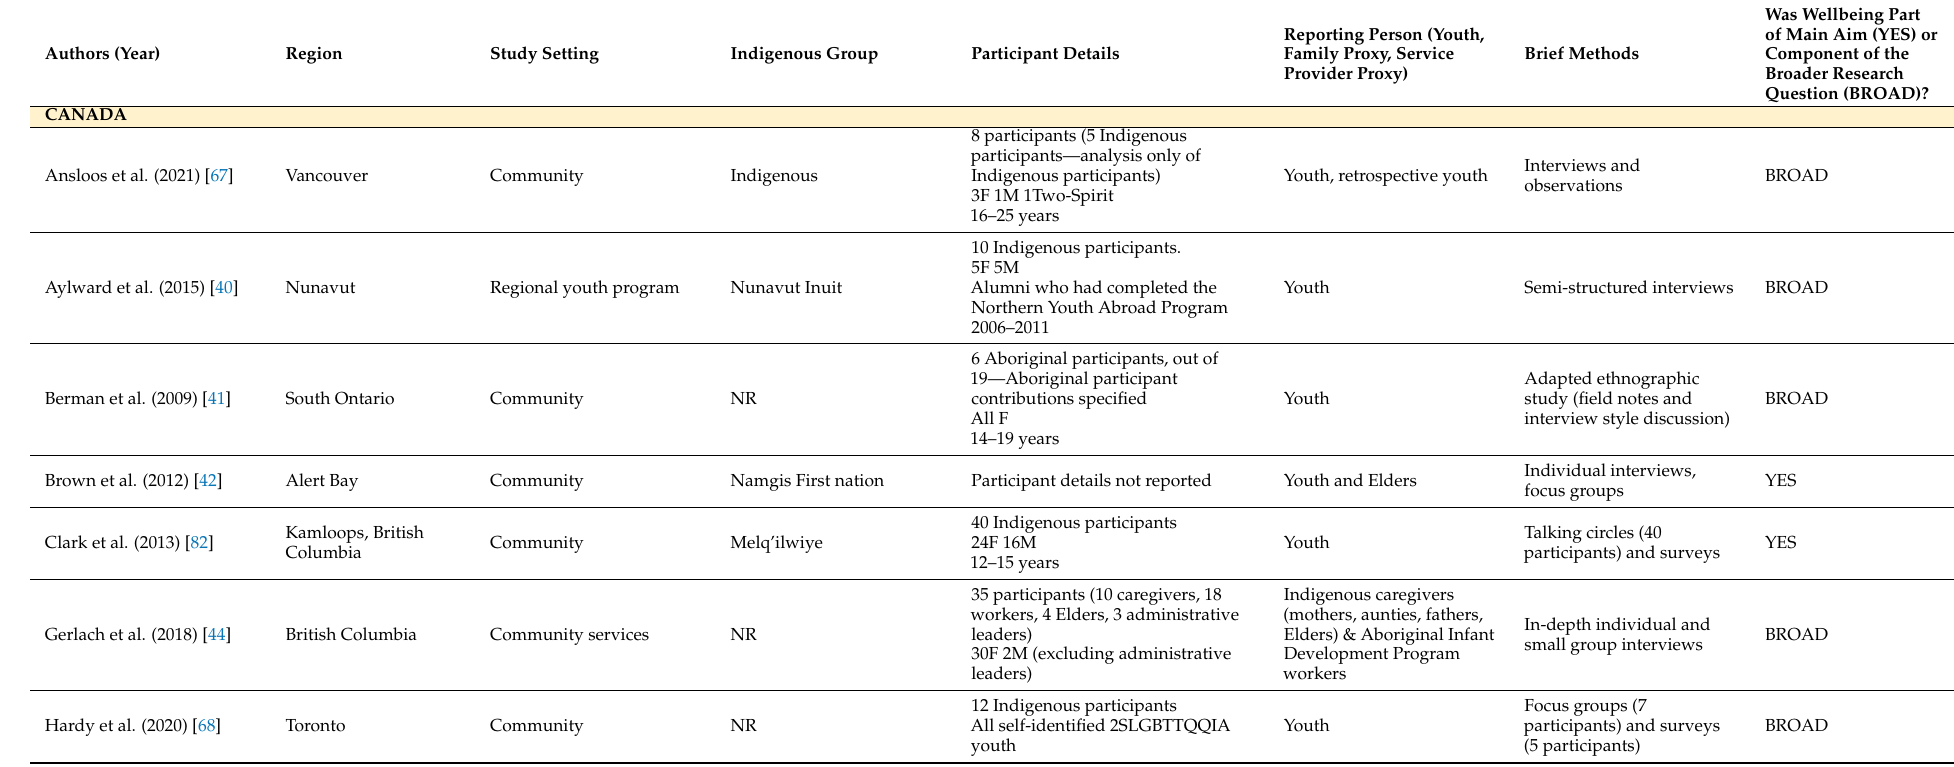
Table 2. Included articles, details and participants